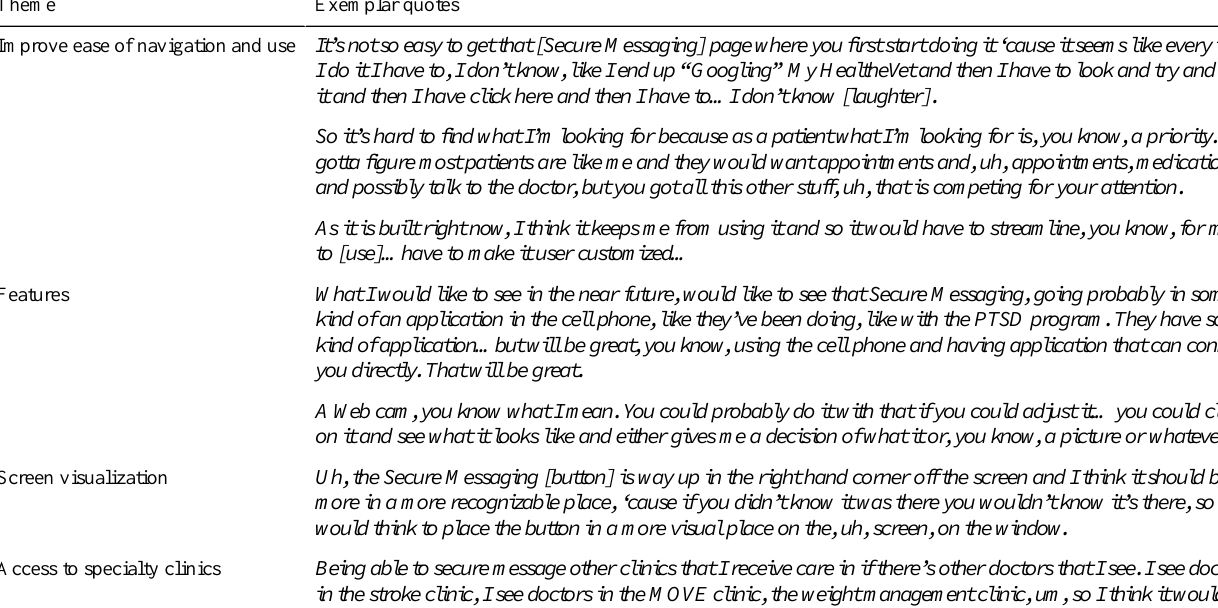
Table 6. Exemplar quotes of suggestions to improve Secure Messaging. Exemplar